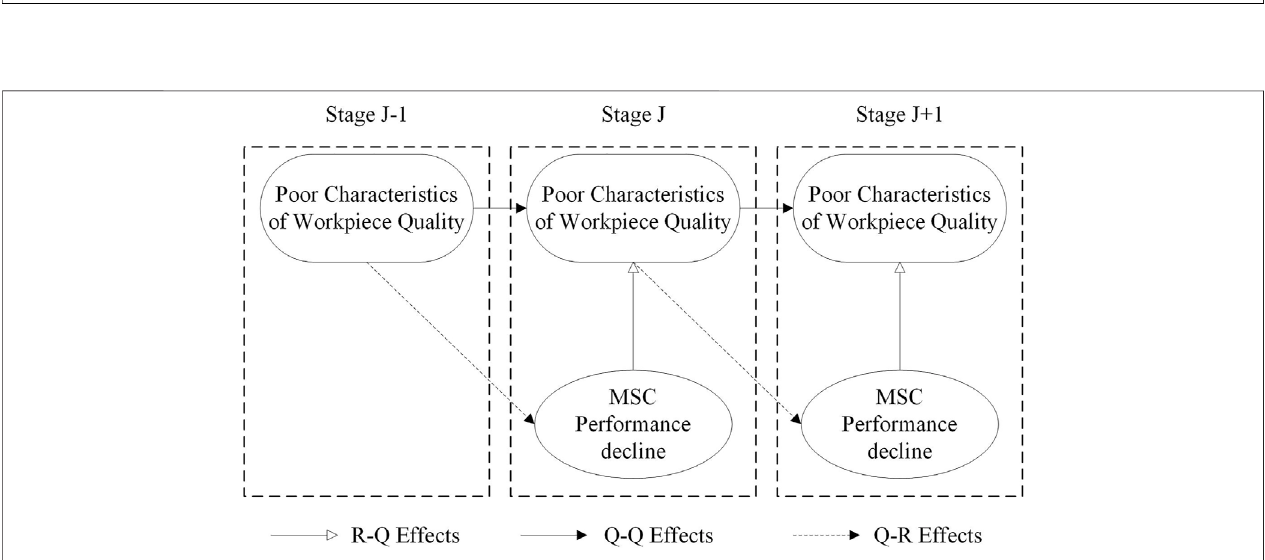
FIGURE 3 | Quality-reliability coupling relationship of a machining stage.